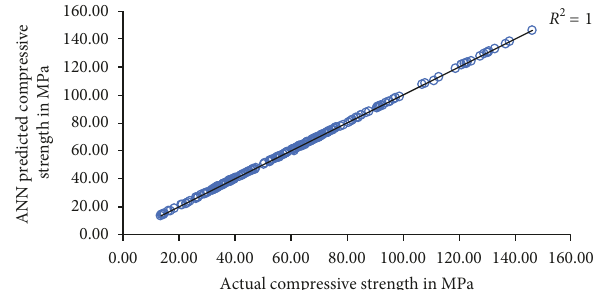
Figure 2: Actual vs. ANN predicted value for compressive strength.